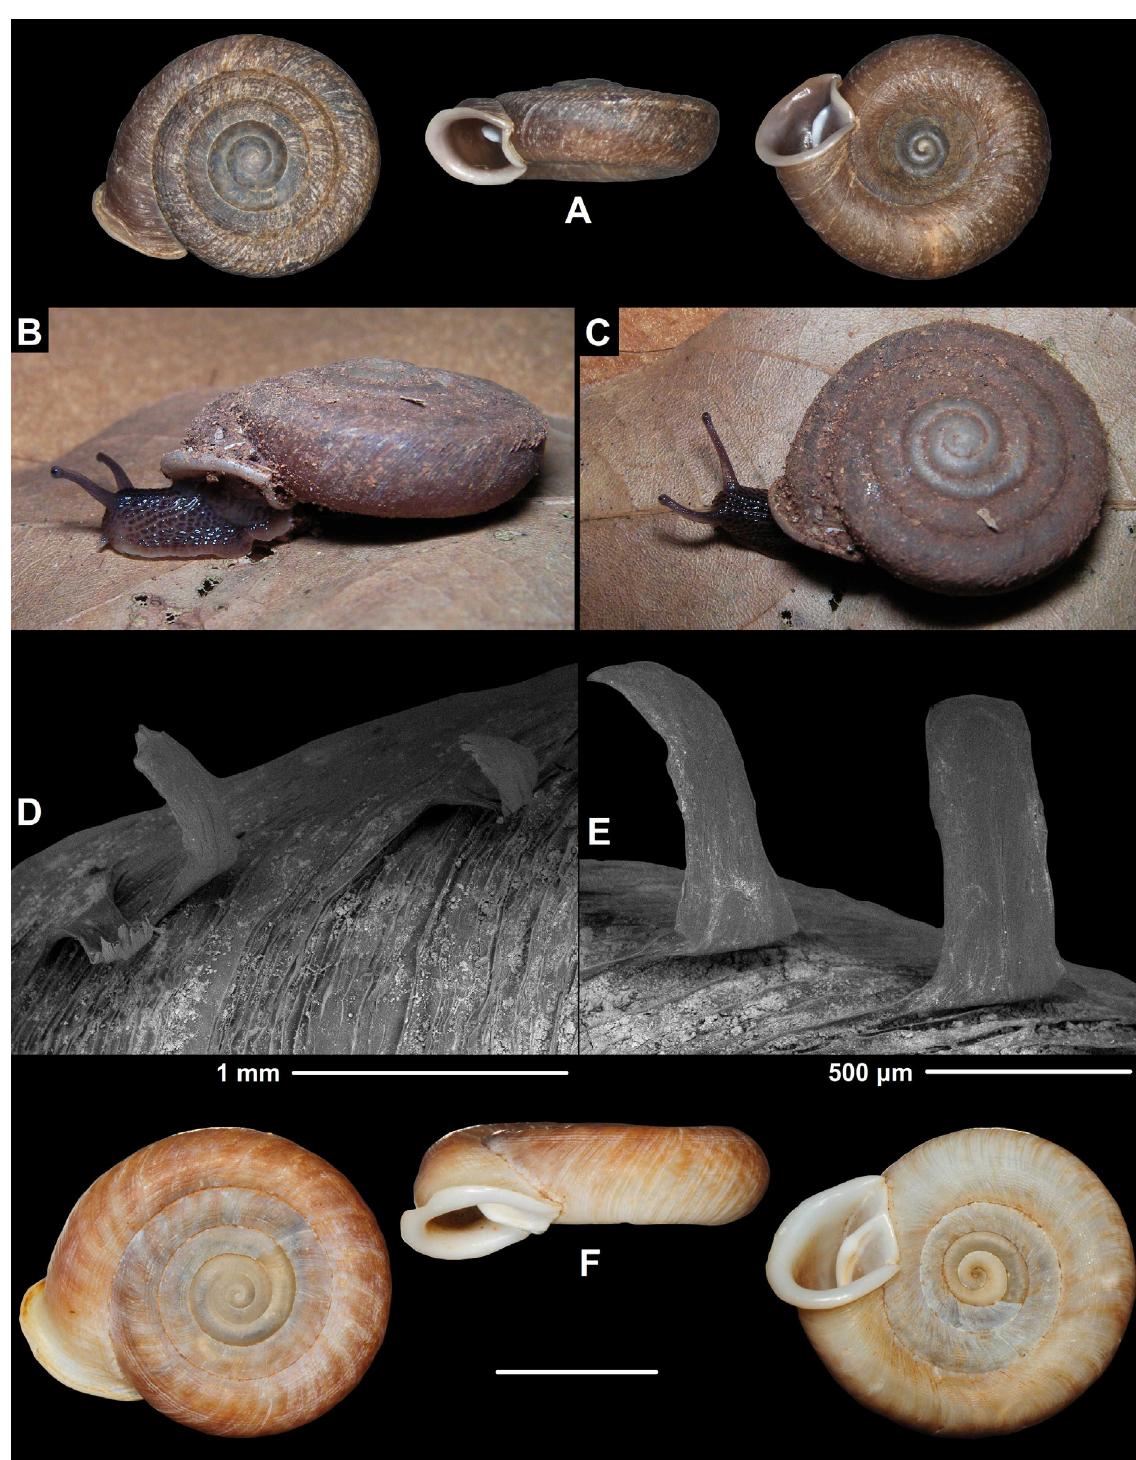
Fig. 44. Shells of species of Plectopylis Benson, 1860. A . P. malayana sp. nov., holotype (HNHM 97469). B–C . Living specimen of P. malayana sp. nov. D–E . SEM images of the periostracal folds of P. malayana sp. nov., specimens from loc. 2013/14. F . P. thompsoni sp. nov., holotype (UF 77249). Scale bars: A, F (lower scale) = 10 mm. Images: T. Deli (A, F), T.-S. Liew (B–C) and B. Páll-Gergely